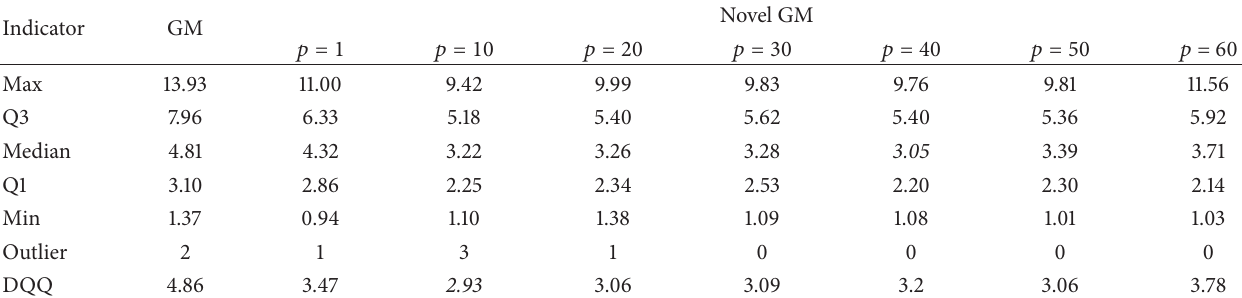
Table 3: Values of indicators in box plot of RMSEs at different values of 𝑝 in the novel GM and GM. Indicator